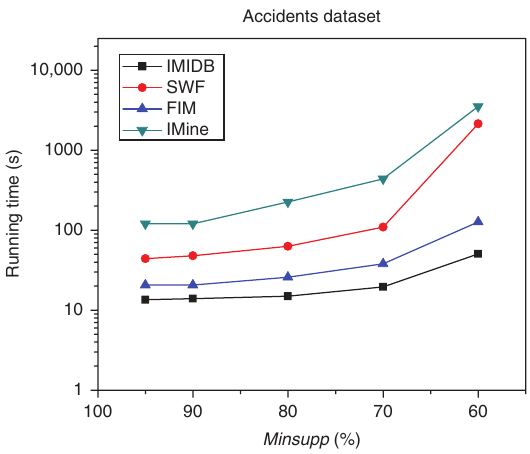
Figure 9: Running Time Comparison – Accidents